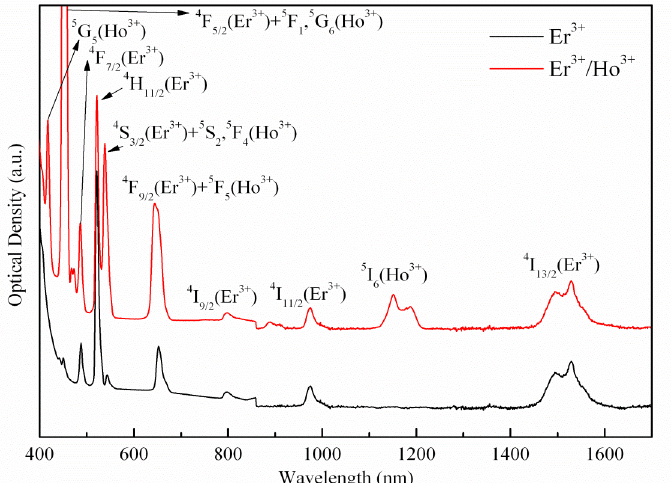
Figure 1. Absorption spectra of Er 3+ and Er 3+ /Ho 3+ -codoped samples.